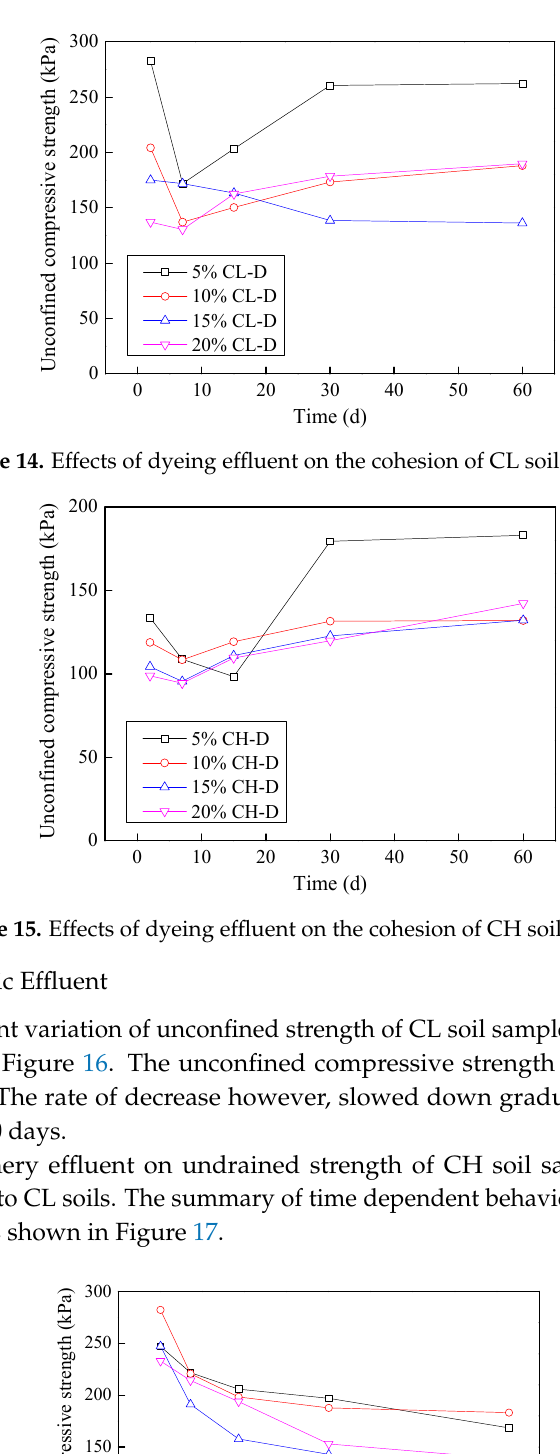
CL-D Figure 13. Effects of industrial effluents on compression index of cohesive soils. 3.8. Time ‐ Dependent Variation of Unconfined Compressive 3.8.1. Effects of Acidic Effluent In order to study the time dependent effects of leachate contamination on cohesive soils, specimens prepared at different contamination percentage were preserved in controlled environment for up to 60 days. The results of unconfined compression tests performed on CL soil samples contaminated with dyeing effluent are shown in Figure 14. The unconfined compressive strength for 15% CL ‐ dyeing constantly decreased from 2 days to 2 months, while the unconfined compressive strength for the other samples began to increase after 7 days. However, the final strength after 60 days was still less than the unconfined compressive